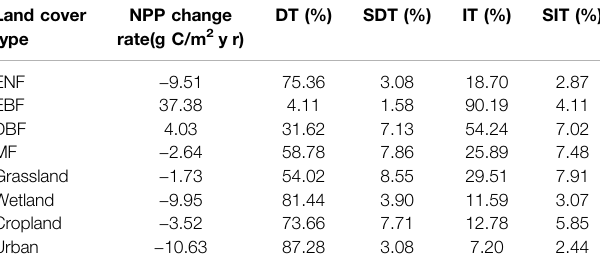
TABLE 4 | Rate of NPP change for each land cover